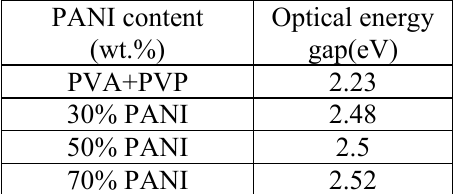
Table 1: The optical energy gap of polyaniline and additive level.